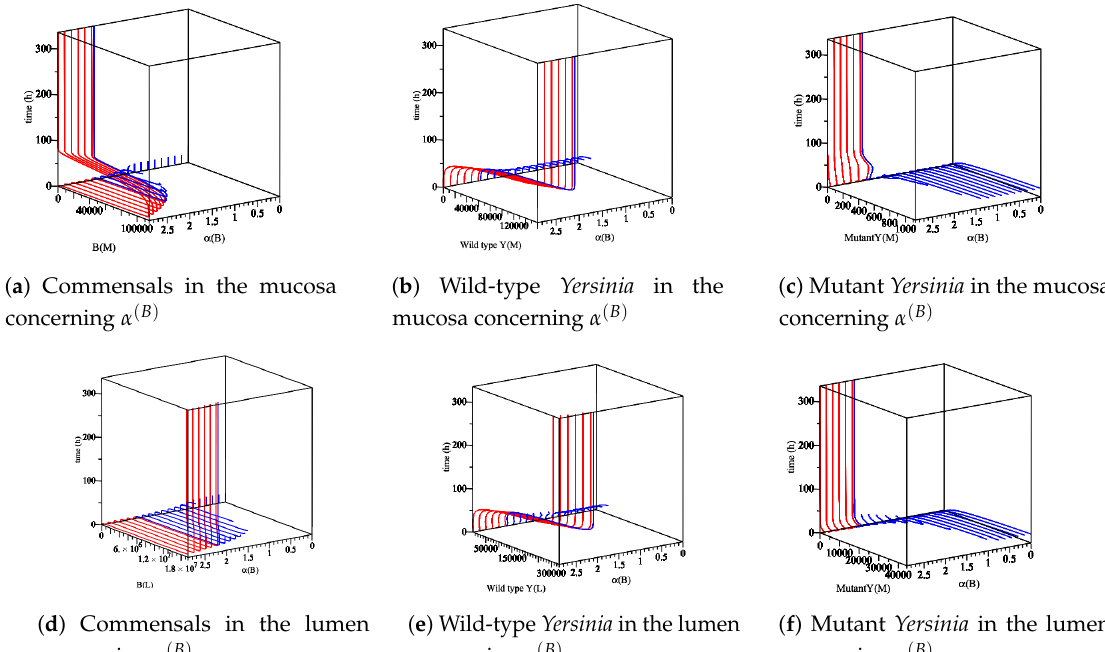
Figure 5. The sensitivity of parameter α ( B ) with respect to commensal bacteria, wild-type, and mutant Yersinia in the mucosa and lumen for 336 h. 0 < α ( B ) < 1, no biologically meaningful region (out of our interest). α ( B ) > 1, all populations appear. When 1 < α ( B ) < 2.28, the region is a region